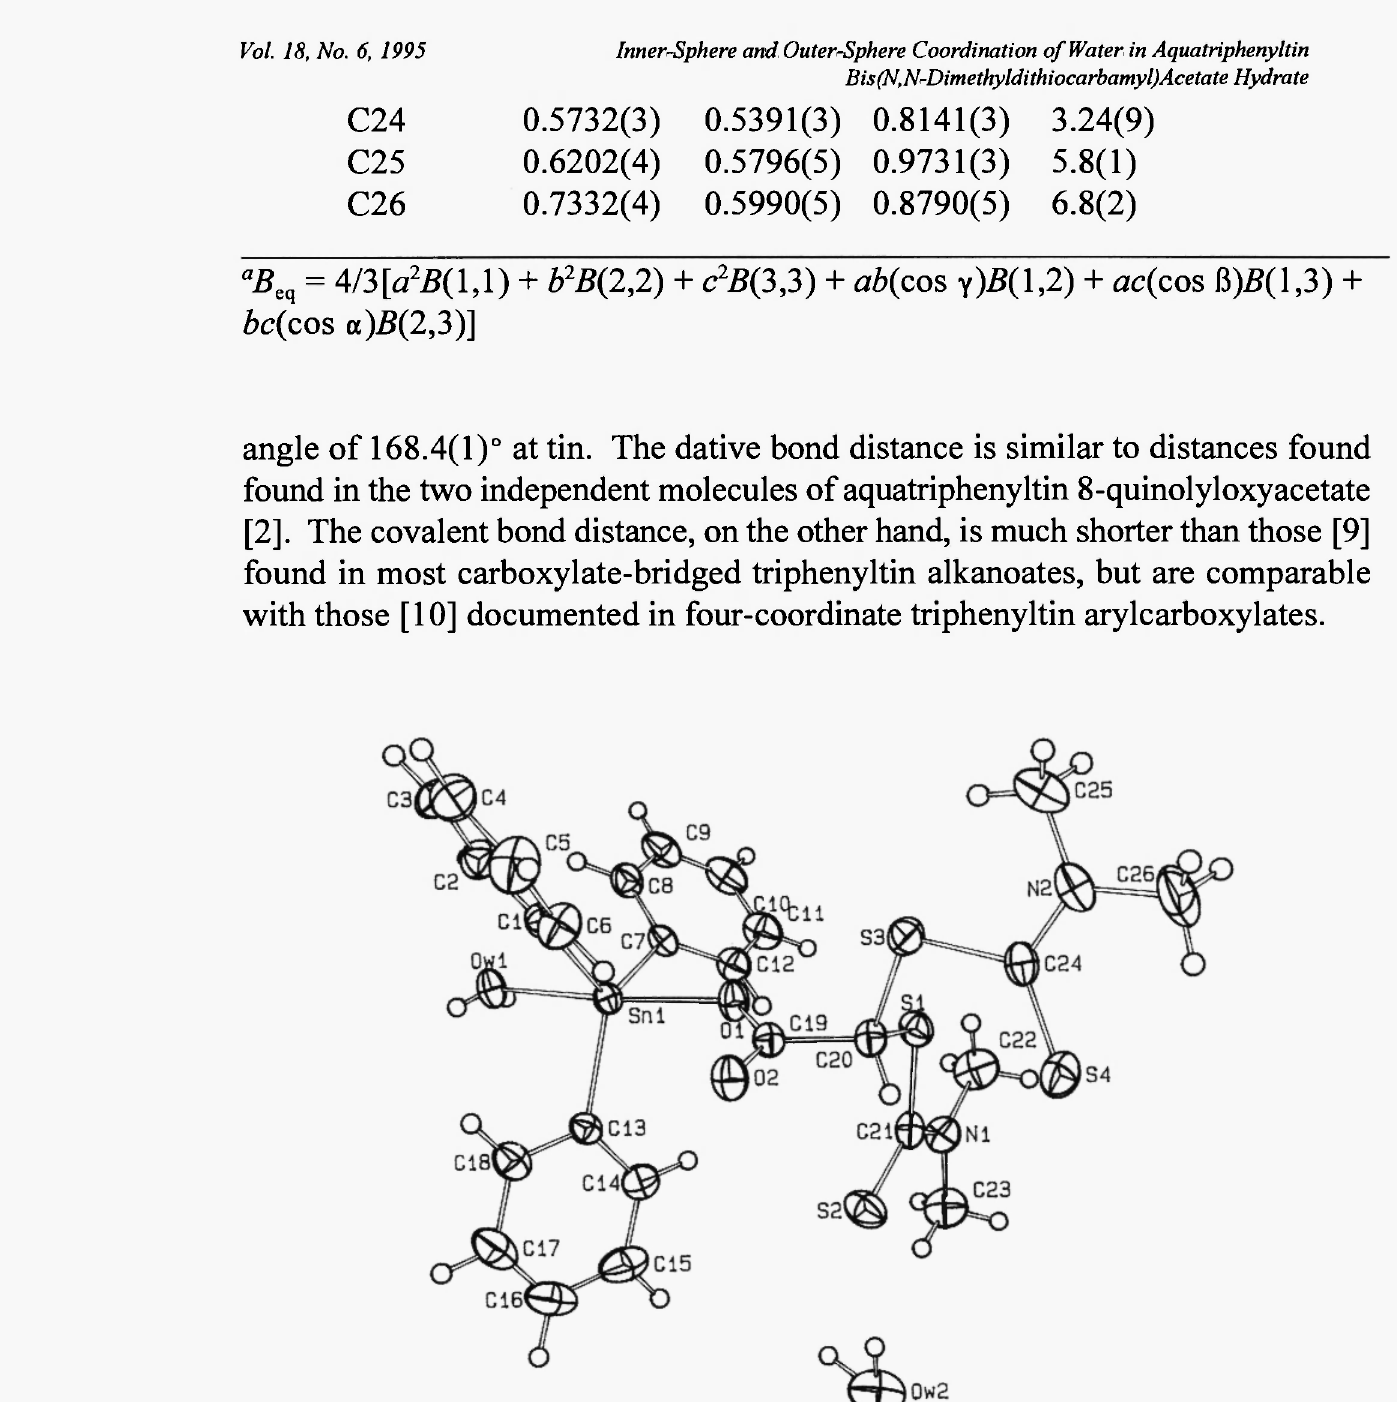
Fig. 1 . Geometry of the tin atom in aquatriphenyltin bis(AyV-dimethyldithiocarba- myl)acetate hydrate. Selected bond distances and angles: Snl-Ol = 2.160(3), Snl-Owl = 2.388(3), Snl-Cl= 2.129(4), Snl-C7 = 2.133(4), Snl-C13 = 2.114(4) Ä; Ol-Snl-Owl = 168.4(1), Ol-Snl-Cl = 99.0(1), 01-Snl-C7 - 85.9(1), 01-Snl-C13 = 97.0(1), Owl-Snl-Cl = 88.4(1), Owl-Snl-C7 = 82.7(1), Owl-Snl-C13 = 87.6(1), Cl-Snl-C7 = 118.2(2), Cl-Snl-C13 = 116.6(2), C7-Snl-C13 =